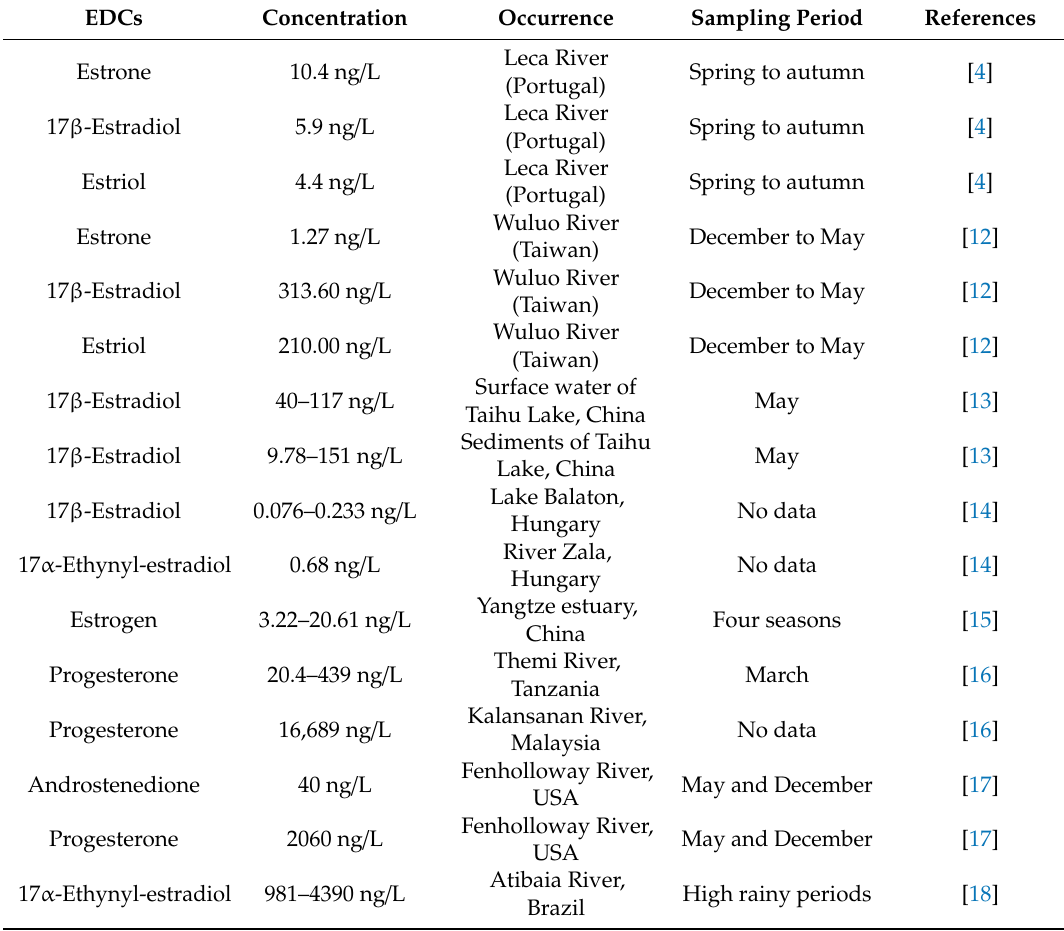
Table 1. Occurrence of EDCs in the